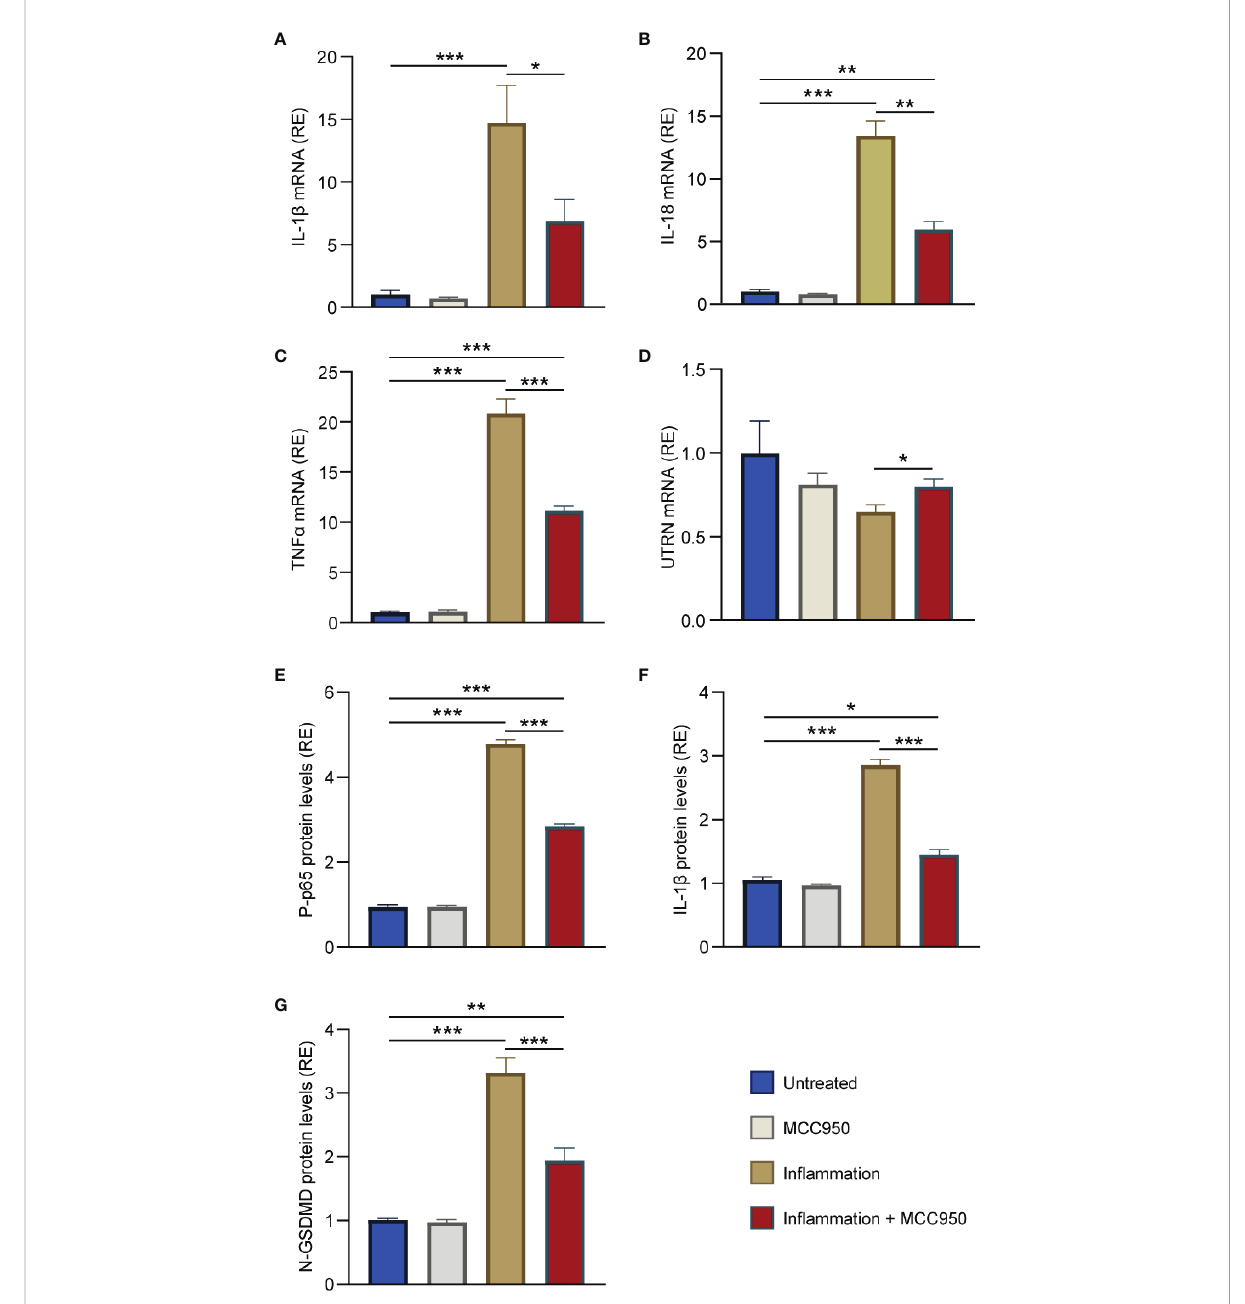
FIGURE 7 MCC950 treatment lessens in fl ammation and pyroptosis in challenged myotubes from DMD patients. (A-D) mRNA levels of IL-1 b , IL-18, TNF a , and UTRN in primary cultures of myotubes obtained from DMD patients. mRNA levels were normalized to human TATA box-binding protein. (E-G) ELISAs were used to quantify the active phosphorylated form of the p65 subunit of NF- k B (P-p65), IL-1 b and N-GSDMD. Absorbance data are presented as relative expression (RE) compared with WT values. Cells were pre-treated or not with MCC950 (10 m M) for 24 h, while being challenged or not with human recombinant TNF a (15 ng/mL) + human interferon gamma (IFN g ) (15 ng/mL) for the last 22 h and then stimulated with ATP (5mM) for the last 2 h. The subsequent ratios are presented as relative expression compared with basal conditions (i.e. no ATP, no in fl ammation and no MCC950, represented by blue columns). Data are means ± SEM for 4 cultures, each obtained from a different donor (i.e., 4 DMD subjects). Statistical analysis was performed on paired data using two-way analysis of variance followed by Sidak ’ s multiple comparison test. * P < 0.05, ** P < 0.01, *** P <